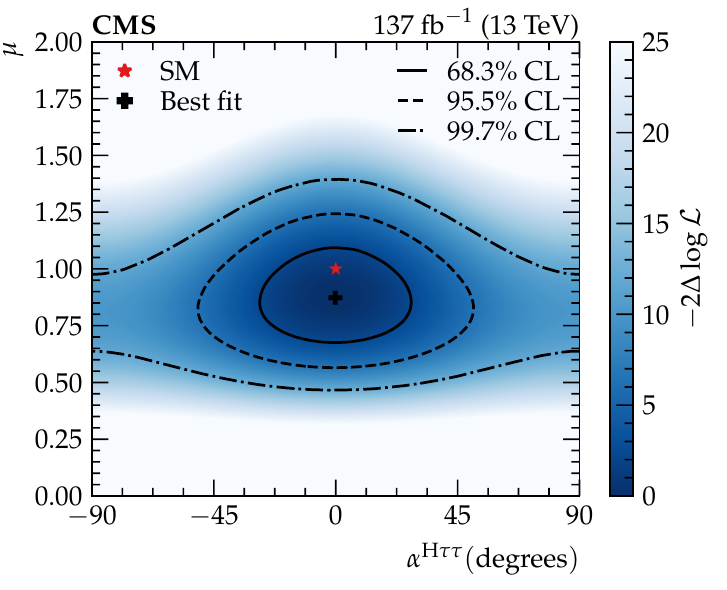
Figure 12 . The 2-D scan of the signal strength modifier µ versus α H ττ . The 68.3, 95.5, and 99.7% confidence regions are